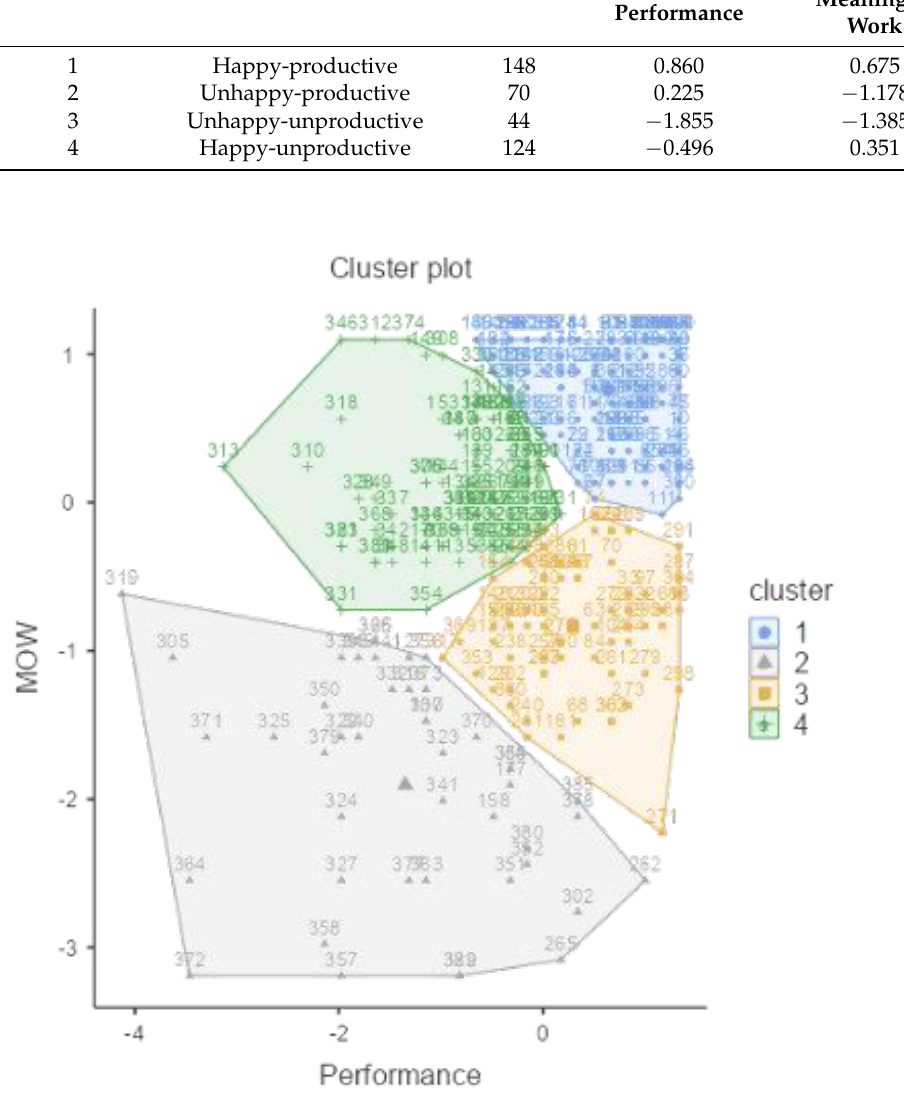
Figure 5. Plot of means across clusters between Job Performance and Meaning of Work. Cluster 1: happy-productive; Cluster 2: Unhappy-productive; Cluster 3: Unhappy-unproductive; Cluster 4: Happy-unproductive. (Study 1; N = 386) (r = 0.43; p < 0.001).